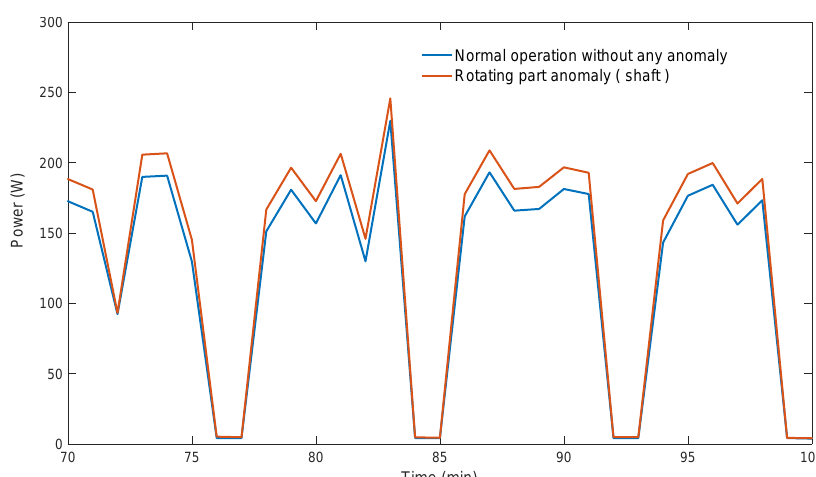
Normal operation without any anomaly Rotating part anomaly ( shaft )